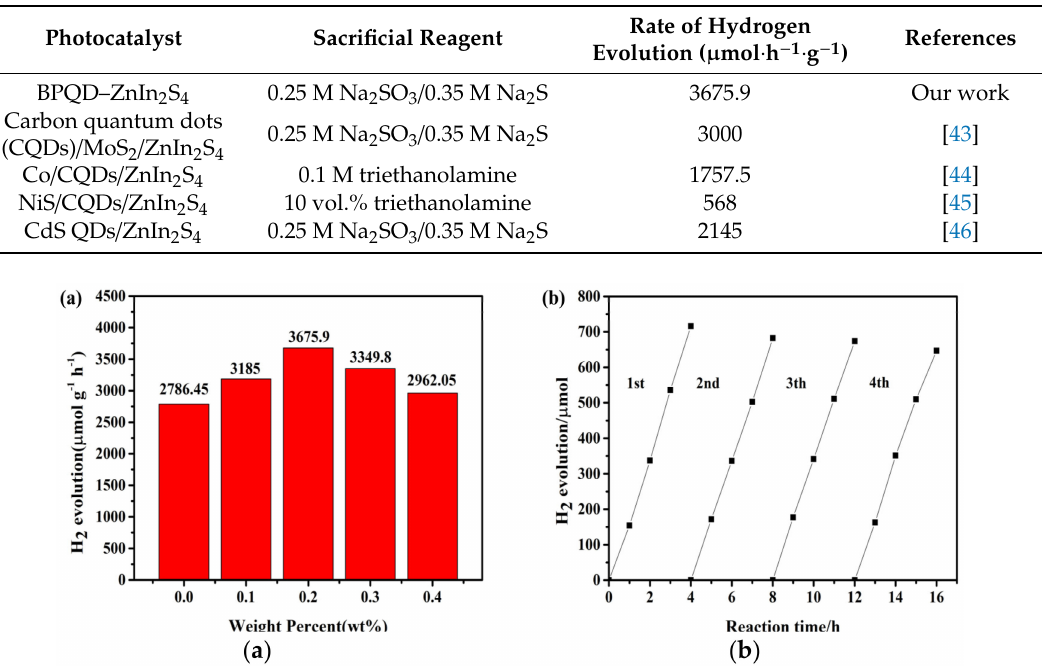
Figure 7. ( a ) H 2 production during 4 h over ZnIn 2 S 4 and BPQD–ZIS hybrids under light irradiation; ( b ) cycled runs for the photocatalytic H 2 generation over 0.2% BPQD–ZIS under light